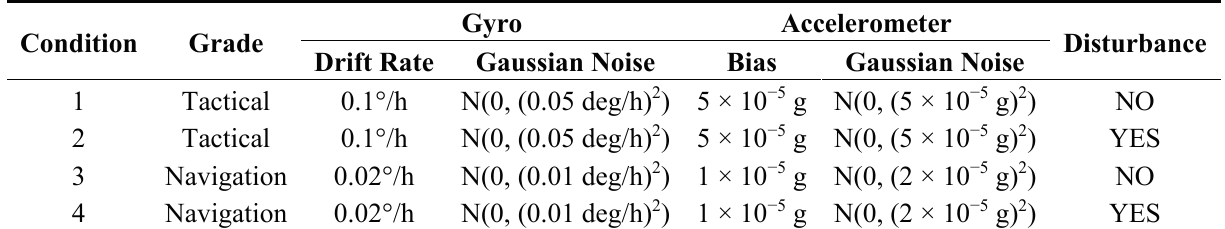
Table 2. Simulation technical data in different conditions.